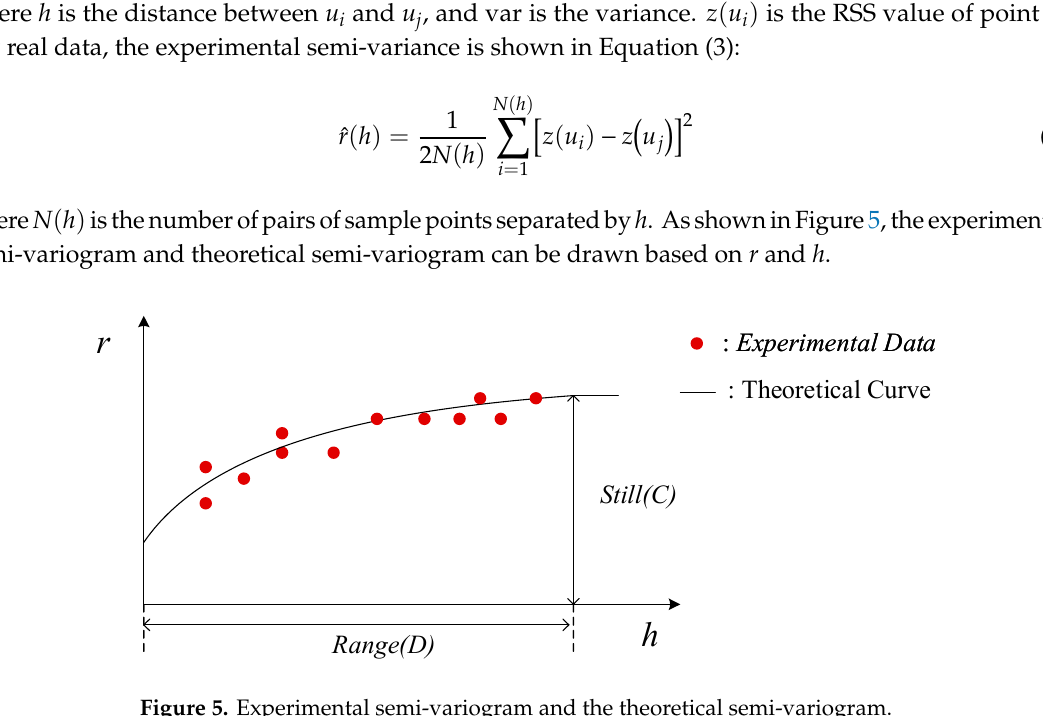
Figure 5. Experimental semi-variogram and the theoretical semi-variogram.